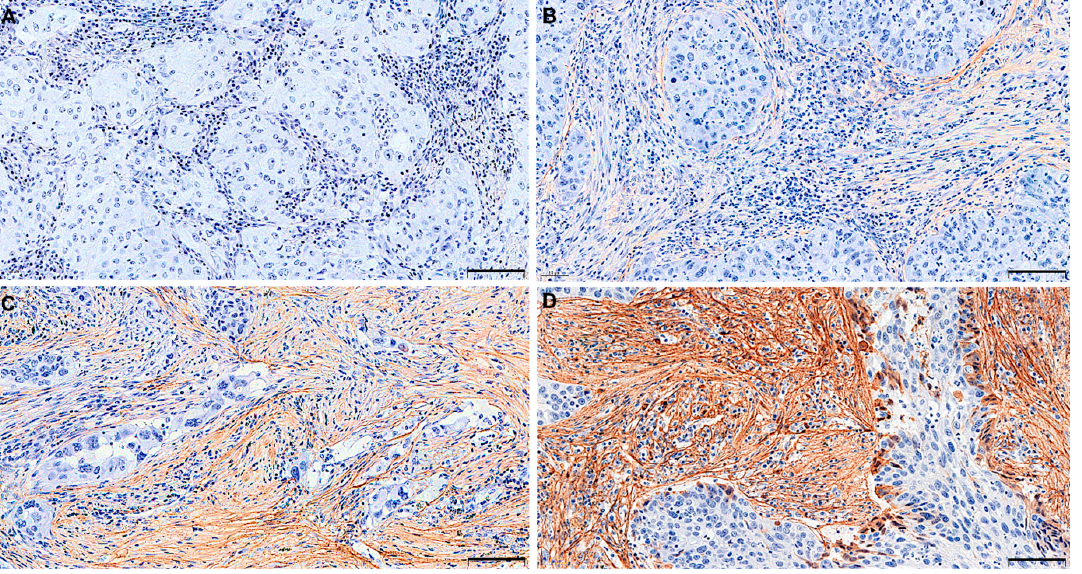
Figure 1. Representative immunohistochemical images with stromal periostin (POSTN) expression in non-small cell lung carcinoma (NSCLC), scored as ( A ) 0—no reaction, ( B ) 1—weak expression, ( C ) 2—moderate expression, and ( D ) 3—strong expression. Magnification 200×. Bar = 100 µm.